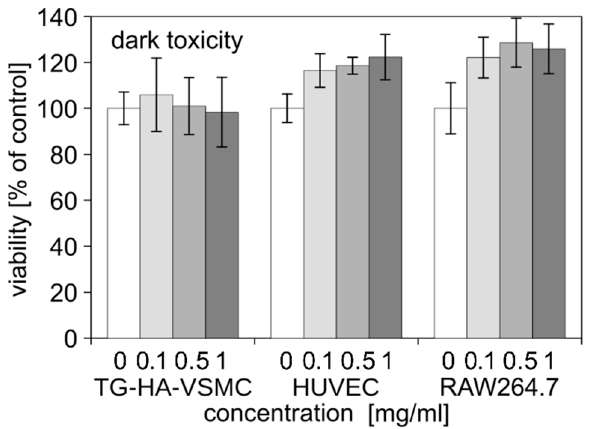
Figure 5. The dark toxicity of liposomal formulation of Photolon in cell lines relevant for atherosclerotic plaque formation. The viability was measured by MTS assay and results are shown as a percentage of untreated control. Averages and standard deviation (SD) are shown.